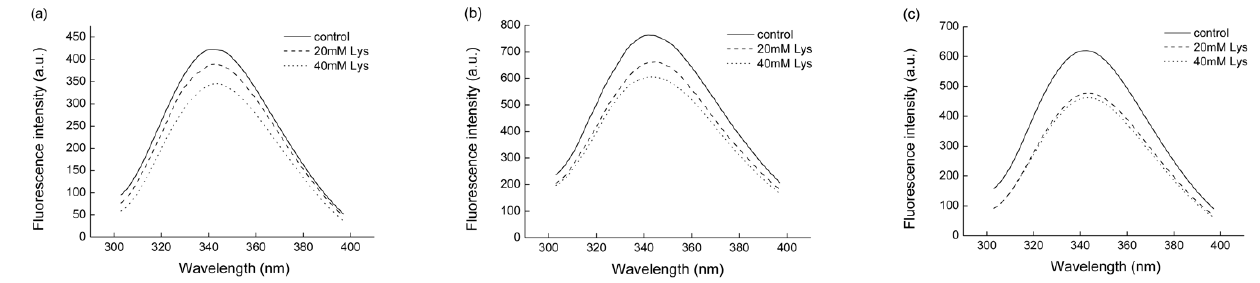
Figure 6. The effects of Lys on the intrinsic tryptophan fluorescence spectra of MFP solutions at different ionic strengths. ( a ) The ionic strength of 0.15 M; ( b ), the ionic strength of 0.3 M; ( c ), the ionic strength of 0.6 M. Control, treatment without Lys addition; 20 mM Lys, treatment with 20 mM Lys; 40 mM Lys, treatment with 40 mM